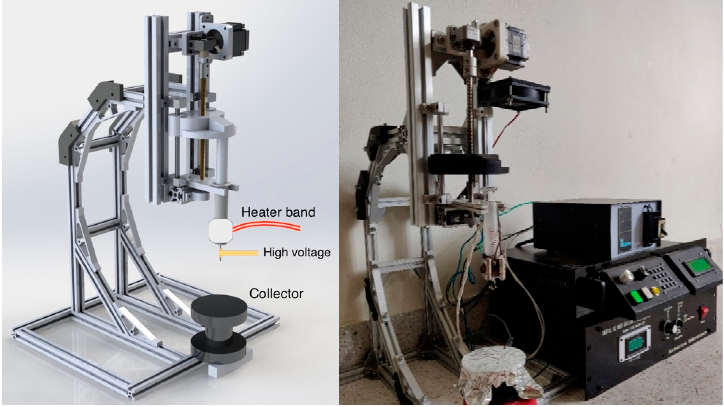
Figure 1. The melt-electrospinning apparatus used in this work.